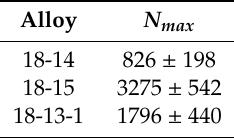
Table 2. The average number of cycles to failure ( N max ) during 2%-strain cycling of the 18-14, 18-15, and 18-13-1 alloys subjected to TMT.